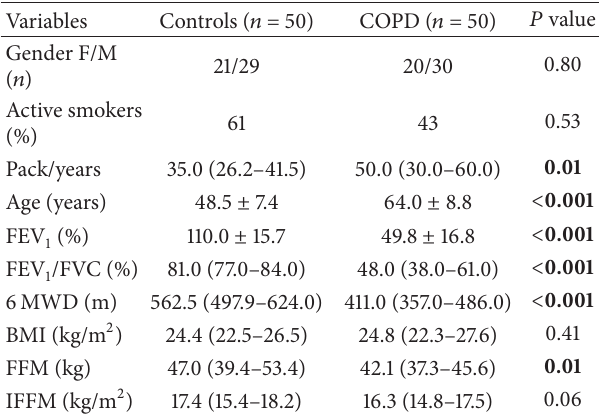
Table 1: General characteristics of individuals grouped according to